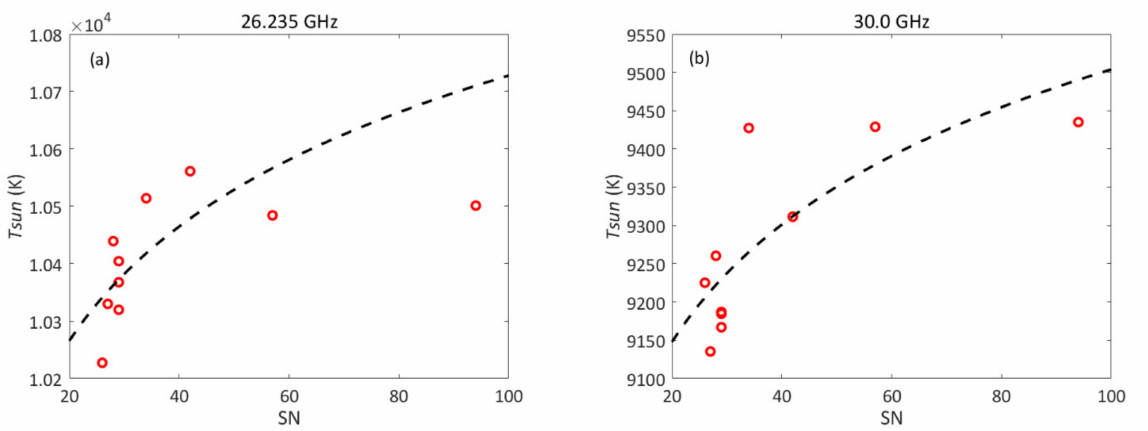
Figure 17. Correlation between the solar TB and the sunspot number. T sun is the solar TB and SN is the sunspot number. The dash line is logarithm trend-line fitting; ( a ) 26.235 GHz and ( b ) 30.0